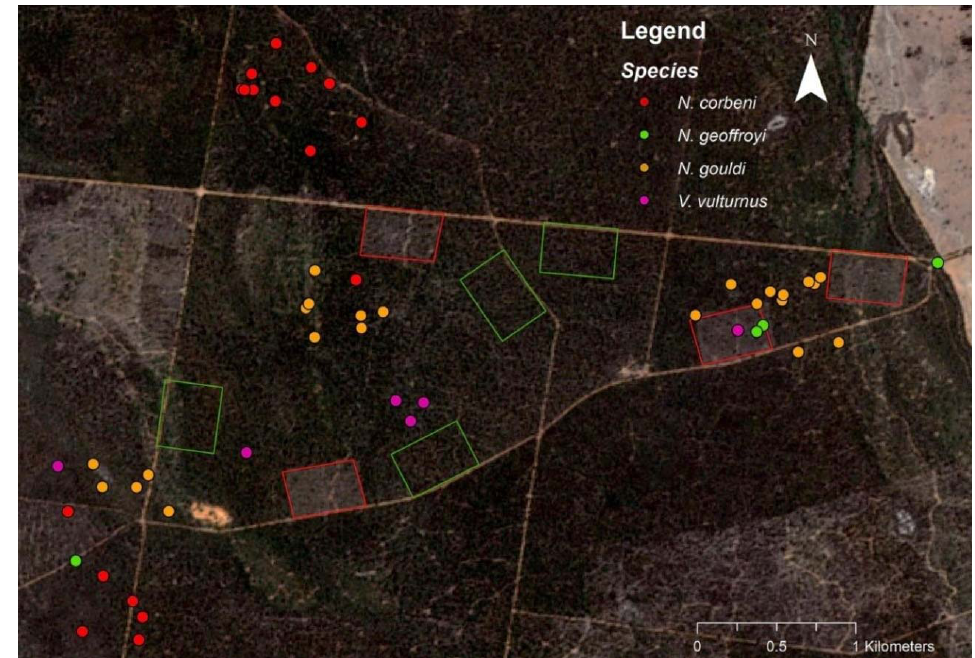
Figure 1. Satellite image (Sentinel ‐ 2) showing the location of roost trees (filled circles) and four 12 ‐ ha thinned blocks (red border) where radio ‐ tagged bats were trapped. Four unthinned controls (green border) are also shown. Larger areas of commercial timber harvesting are also apparent in the southeast and northwest.